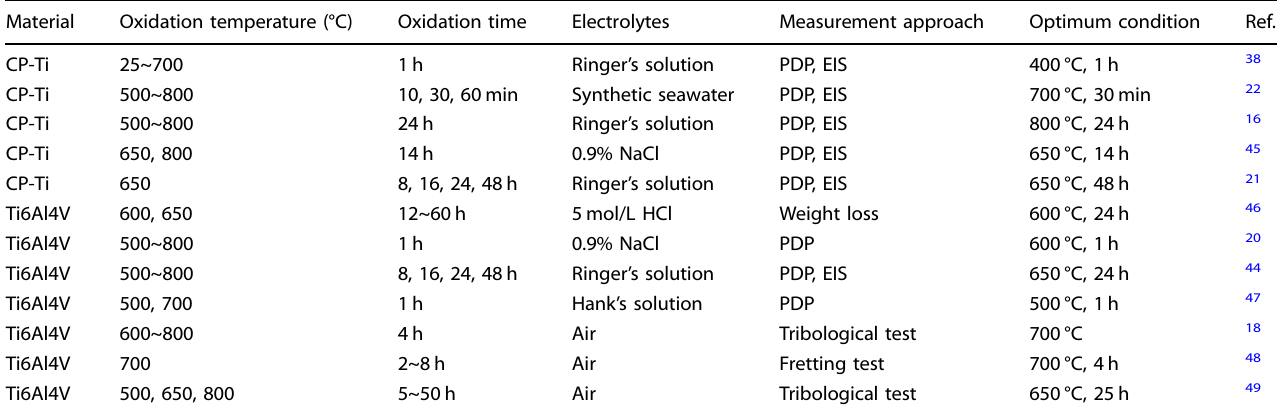
Fig. 8 Corrosion morphologies after immersion in the H 2 SO 4 solutions containing 0.002 M fl uoride for 24 h. As-received pure Ti in the solutions of pH 2 a and pH 0 c , and the thermally oxidized pure Ti (at 650 °C for 24 h) in the solutions of pH 2 b and pH 0 d . Table 1. Summary of the reported optimal temperature and time for oxidation with good corrosion resistance in the